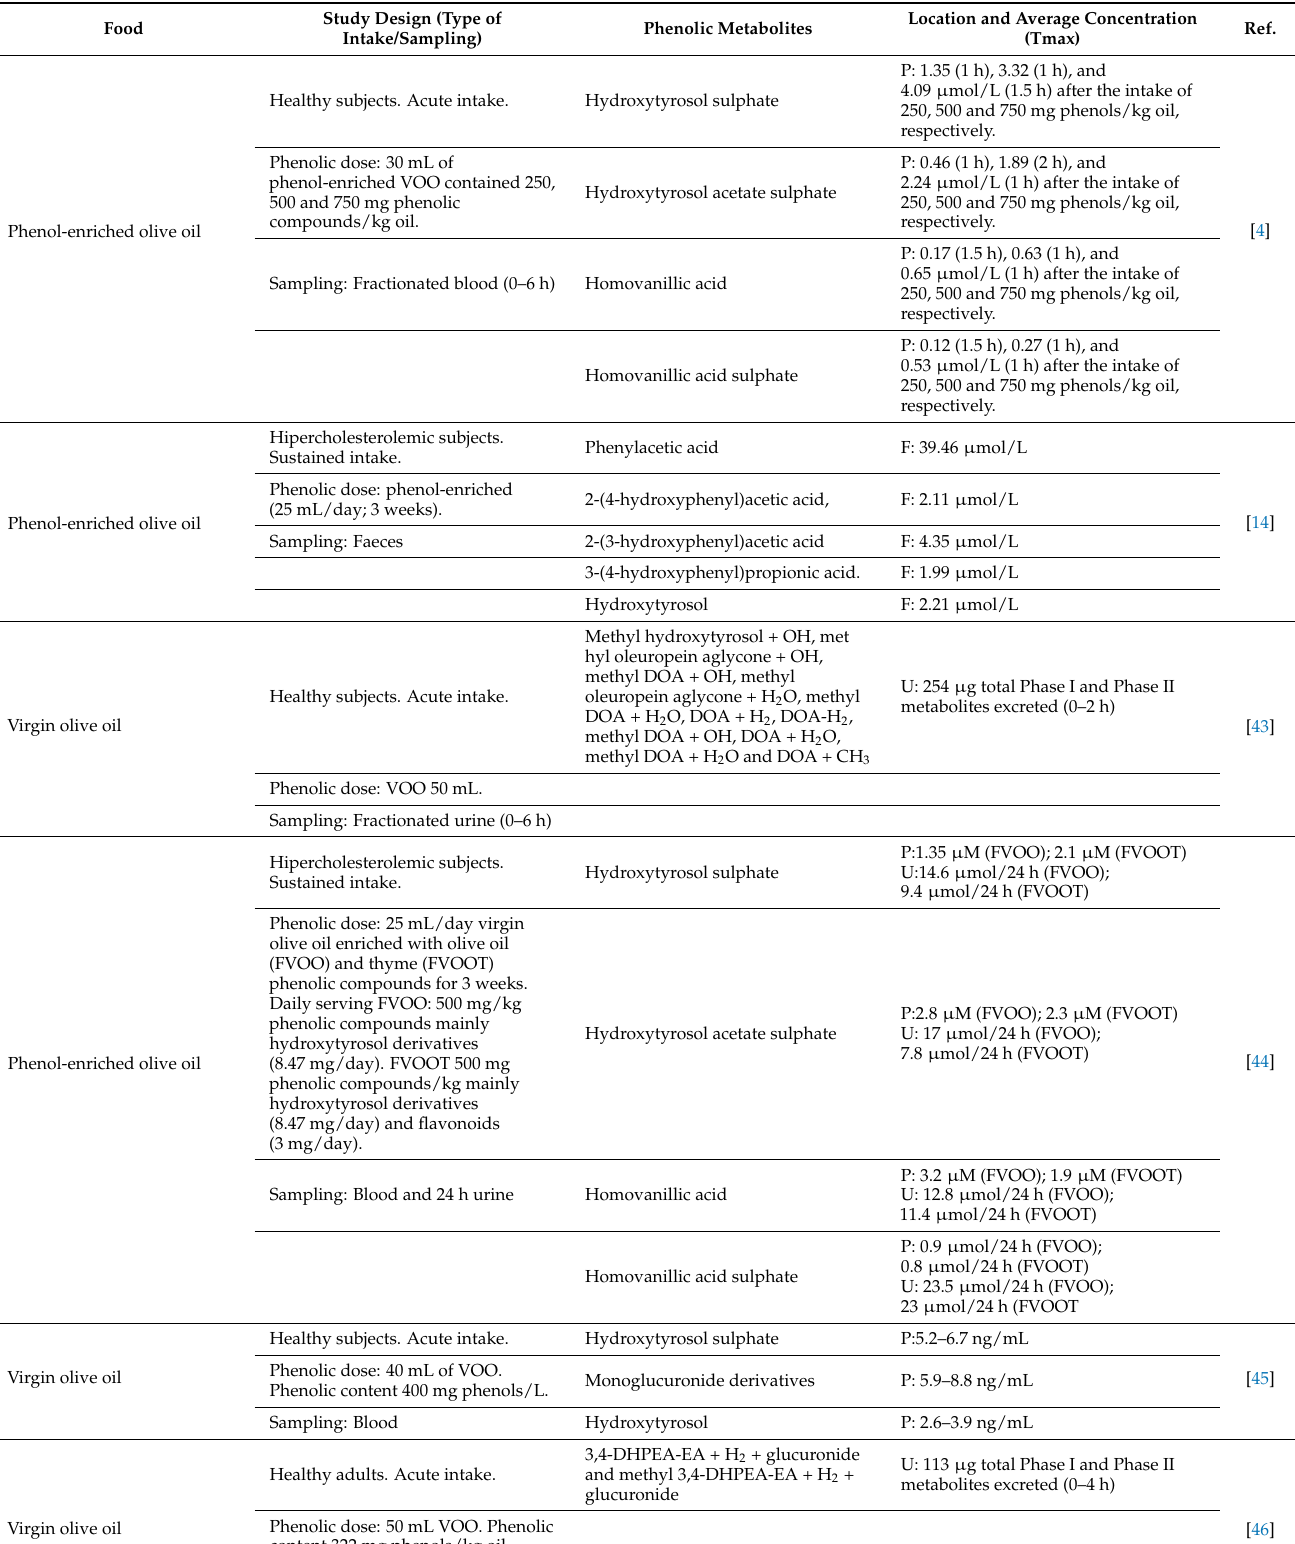
Table 3. Phenol metabolites (phase I, phase II) proposed as intake biomarkers of virgin olive oil. Food Study Design (Type of Intake/Sampling) Phenolic Metabolites Location and Average Concentration (Tmax) Ref.